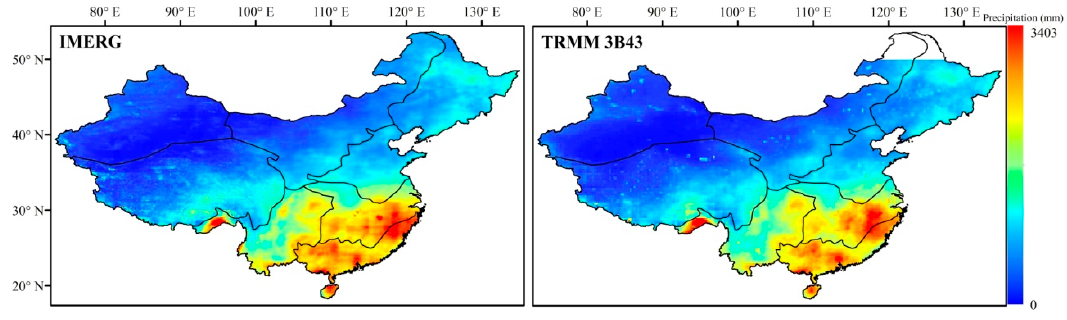
Figure 2. Annual precipitation estimates derived from IMERG and TRMM 3B43 products over Mainland China.